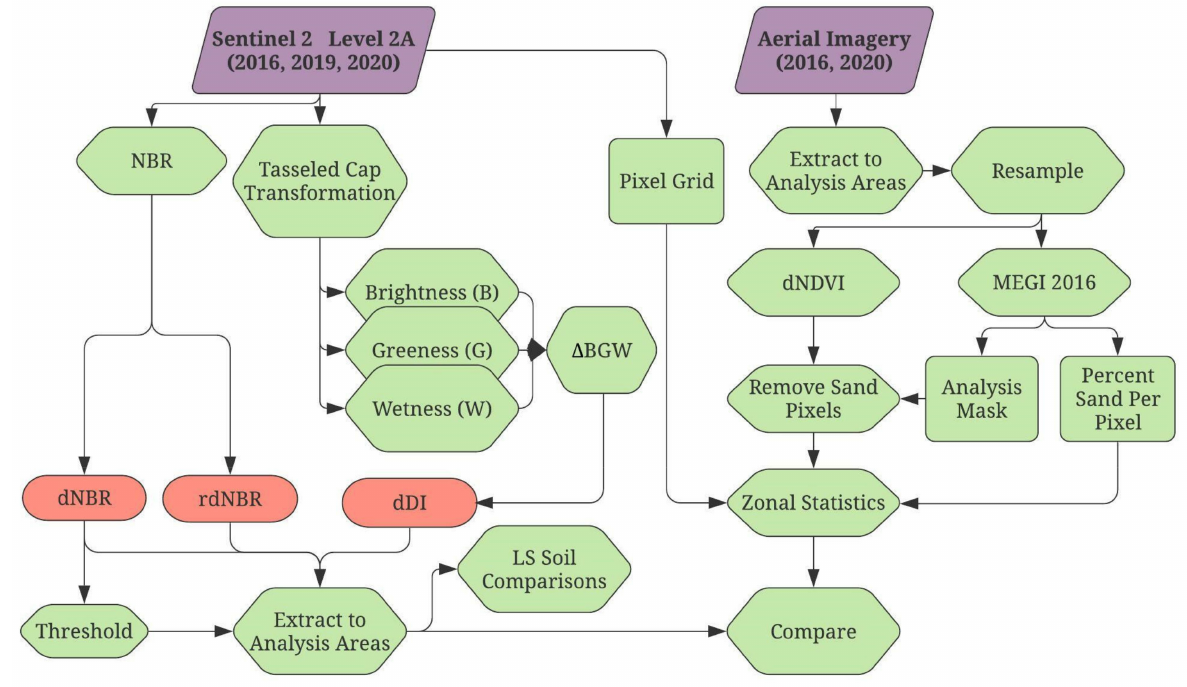
Figure 3. Flow chart of data and methods